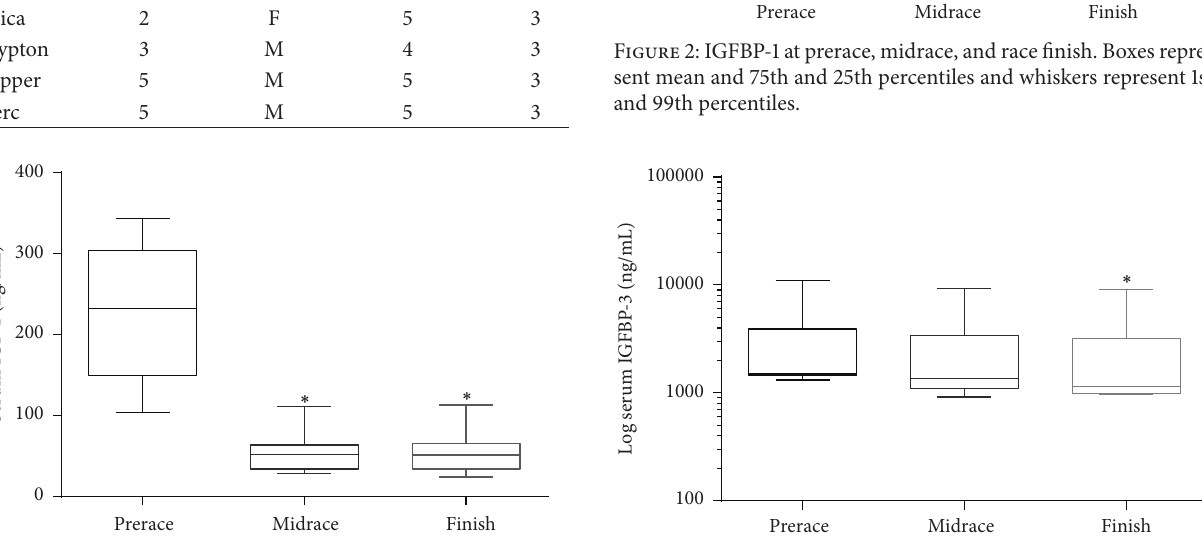
Figure 1: IGF-1 mean and standard deviation at prerace, midrace, and race finish. Boxes represent mean and 75th and 25th percentiles and whiskers represent 1st and 99th percentiles. ∗ indicates a significant difference from the prerace values ( 𝑃 < 0.01 ).